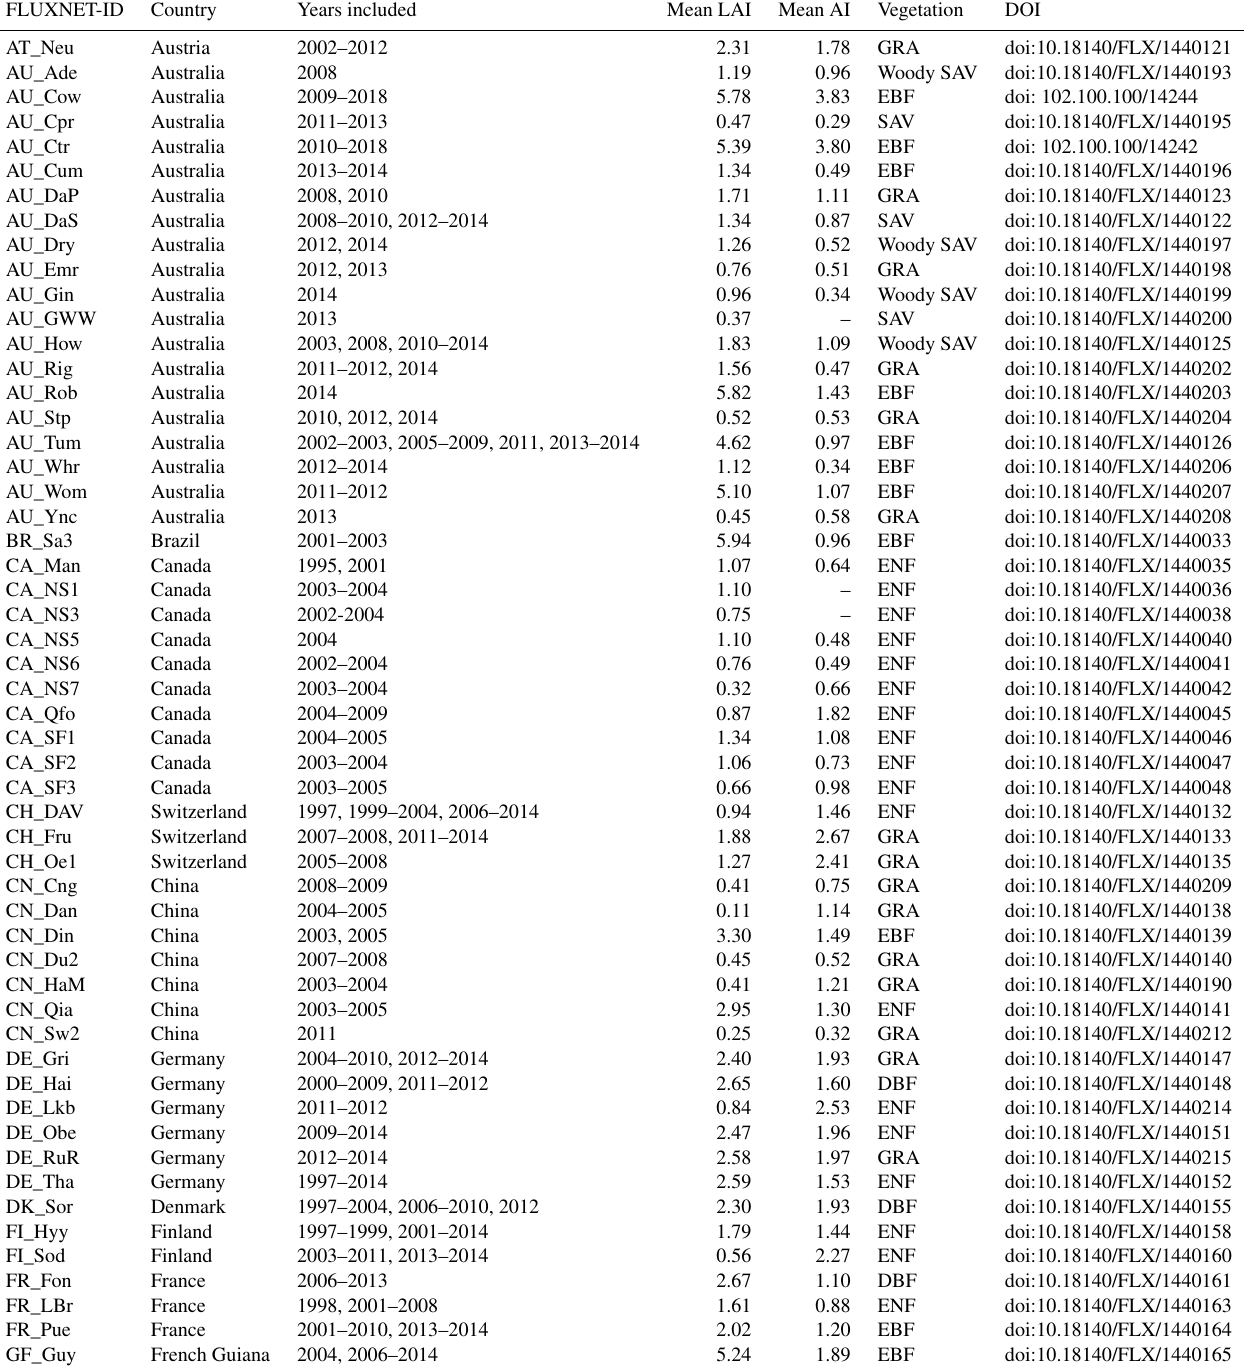
Table 1. A list of all included site-years for the 93 sites. For each site, the yearly average leaf area index (LAI) and aridity index (AI) are calculated for all years included in the dataset. Studied vegetation types include the following: savanna (SAV), woody savanna (woody SAV; savanna and woody savanna sites are combined into one class, “savanna”), grassland (GRA) deciduous broadleaf forest (DBF), evergreen broadleaf forest (EBF), and evergreen needleleaf forest